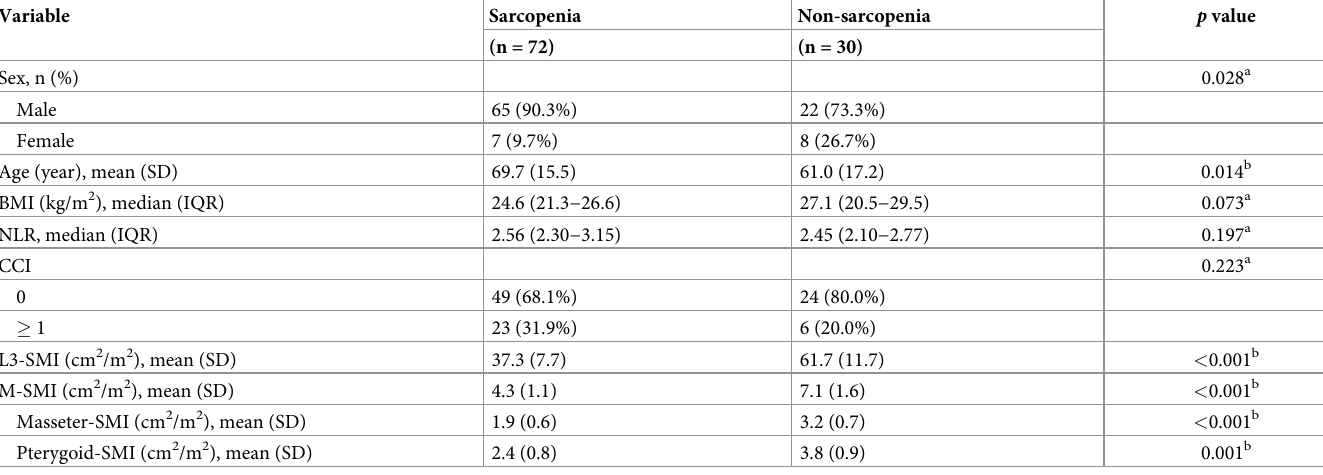
Table 4. Clinicopathological characteristics in patients with and without sarcopenia (n = 102).